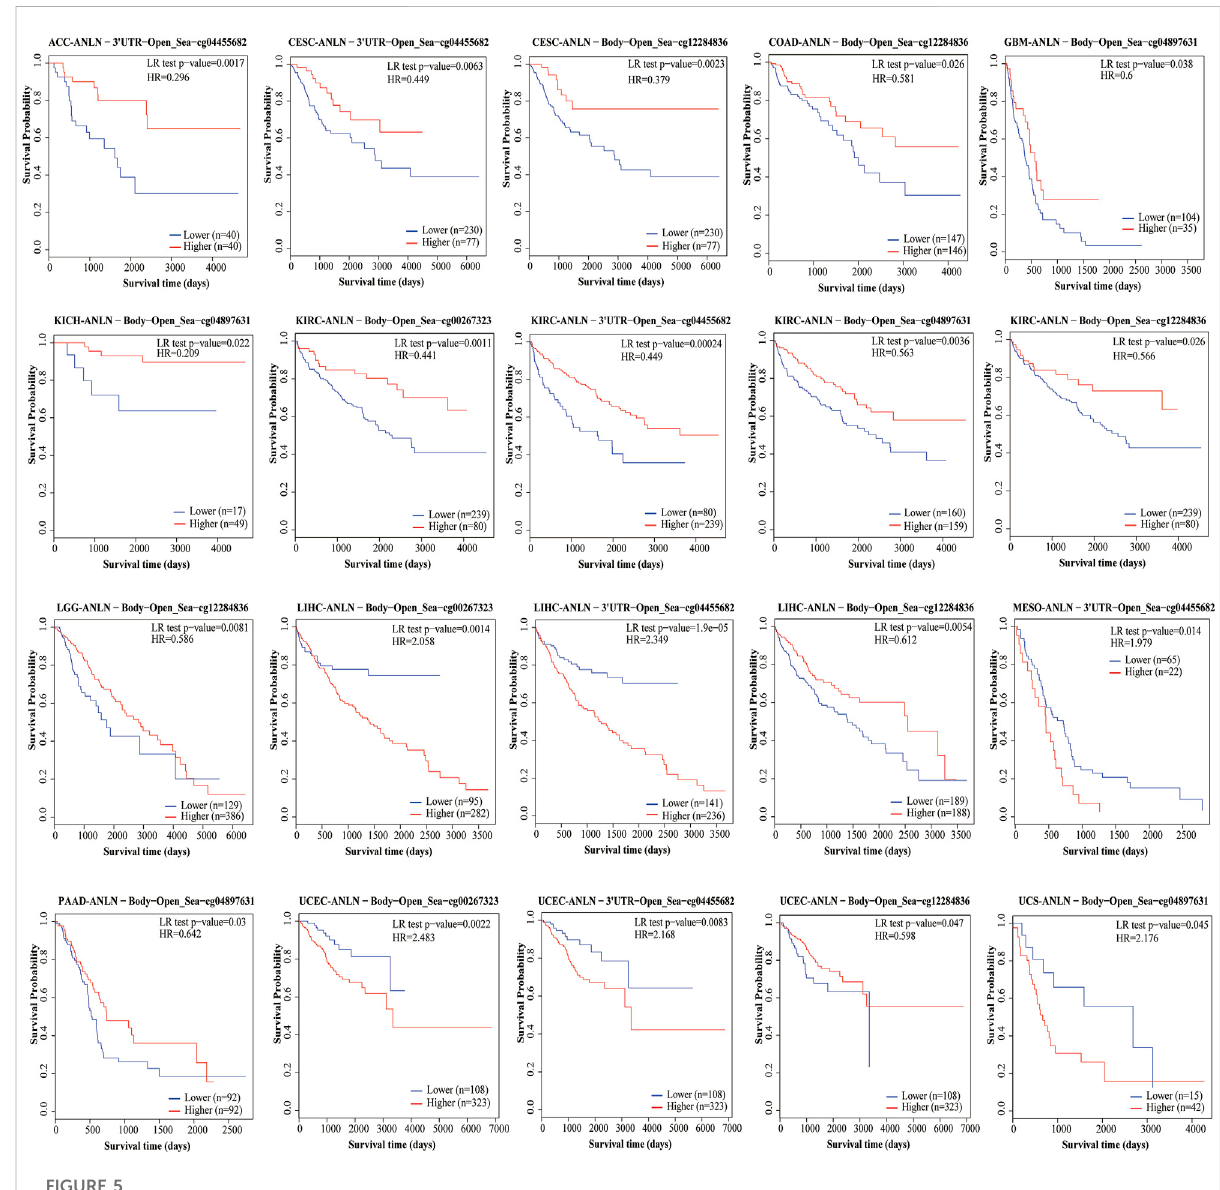
FIGURE 5 The Kaplan-Meier survival of the promoter methylation of